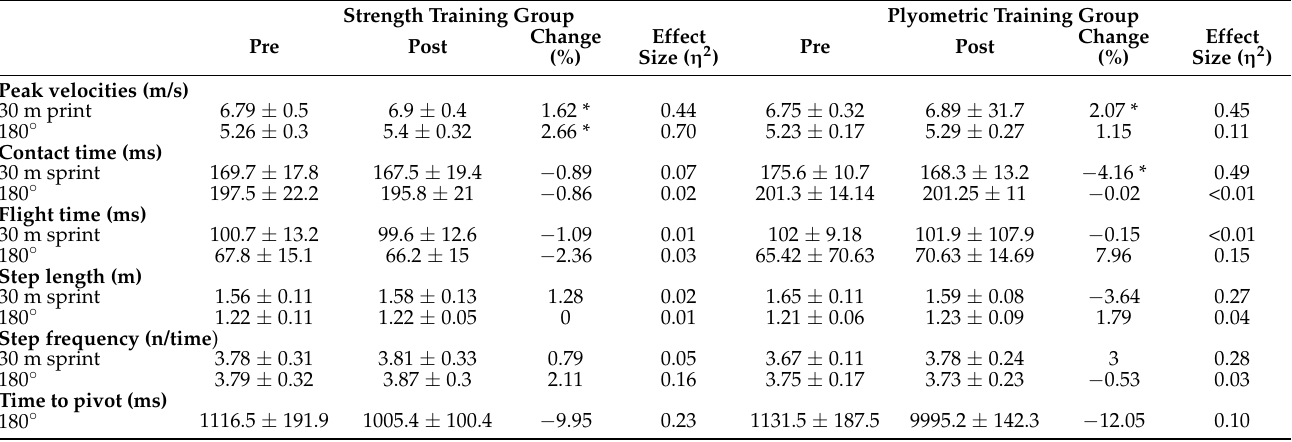
Table 5. Descriptive statistics of changes in step kinematics from pre- to post-test measurements in both